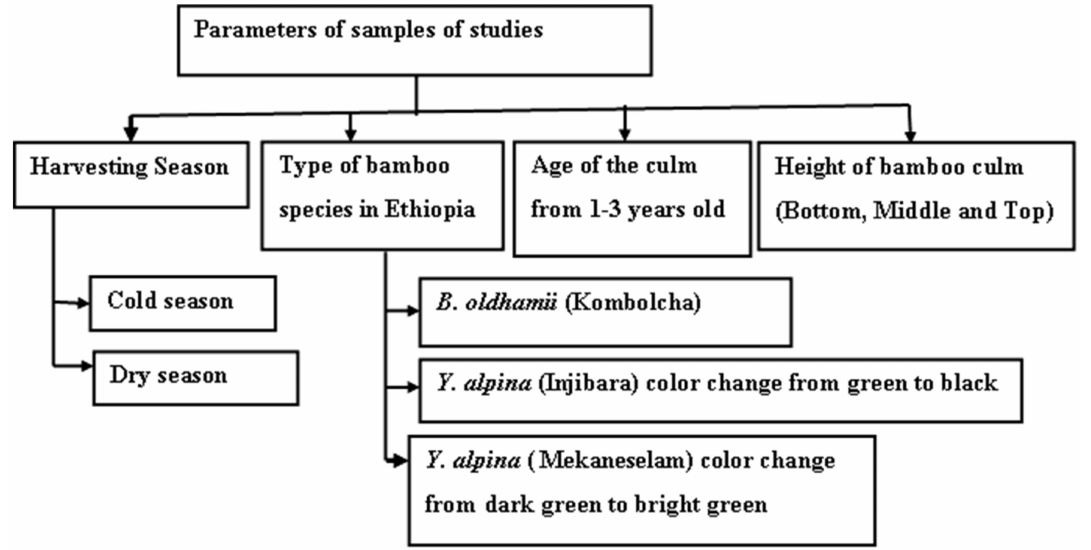
Figure 1. Sample-taking techniques of the bamboo